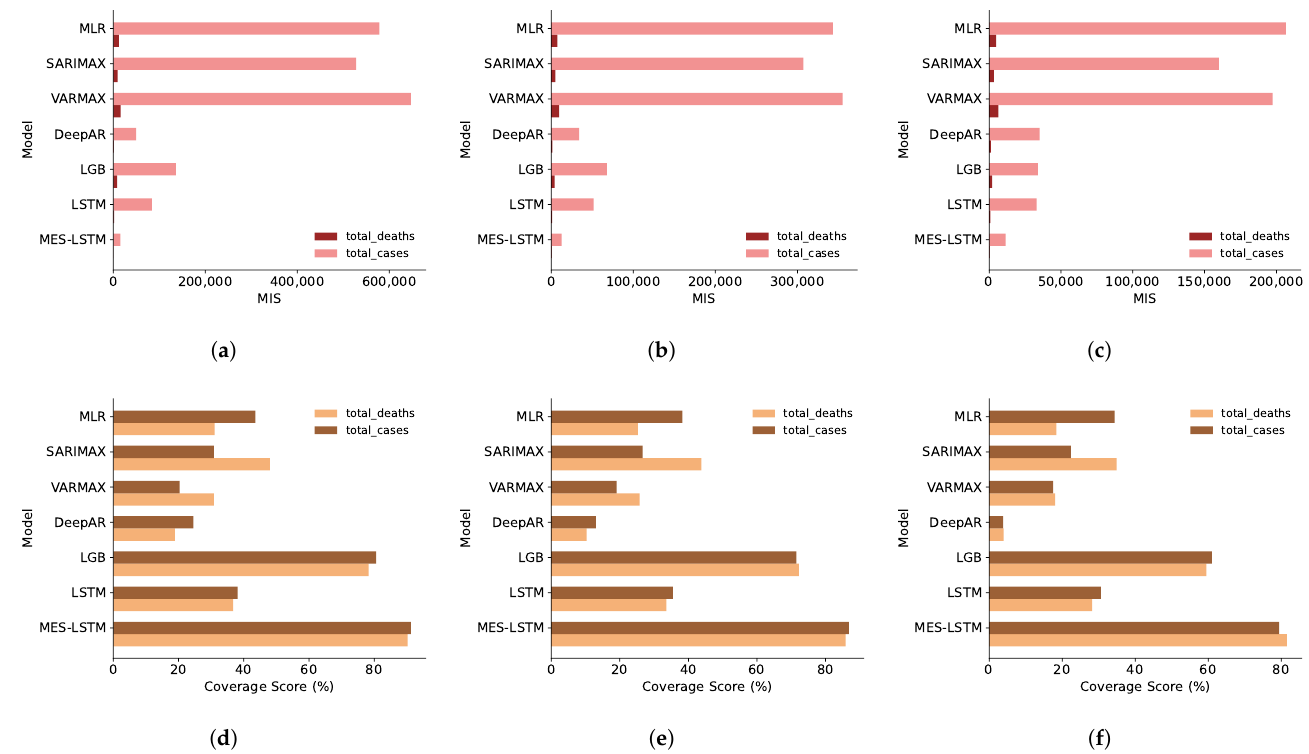
Figure 4. Prediction Interval Accuracy in the SADC Region. ( a ) MIS ( α = 0.05). ( b ) MIS ( α = 0.1). ( c ) MIS ( α = 0.2). ( d ) Coverage Score ( α = 0.05). ( e ) Coverage Score ( α = 0.1). ( f ) Coverage Score ( α = 0.2).